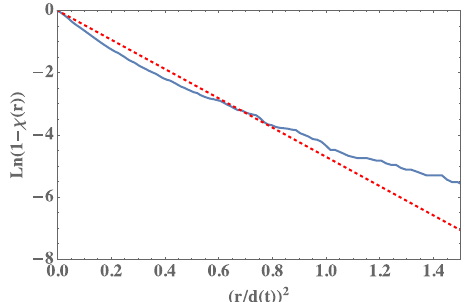
Fig. 3 The “ empty-space" function for a microstructure. The function ln 1 (cid:3) χ r ð Þð Þ versus r / d ( t ) for samples annealed at T = 400 °C for 150 min (blue curve) and, for comparison, for randomly- distributed triple junctions (red dashed triple junctions in synthetically generated microstructures result- ing from a nucleation and growth process 28 ). Knowledge of the pair correlation function implies related knowledge of the distribution of grain sizes. To see this, consider the complementary information that may be obtained from the so-called “ empty-space" function, χ r ð Þ . For an ensemble of triple junctions this function quanti fi es the cumulative probability of the distance from a randomly chosen point to a triple junction 29 . χ r ð Þ is readily calculated for randomly distributed triple junctions in terms of the triple-junction density, ρ = 〈 n ( r ) 〉 / A . Figure 3 shows the logarithm of the survival function, ln 1 (cid:3) χ r ð Þð Þ , as a function of r / d ( t ) for samples annealed at T = 400 °C for 150 min and, for